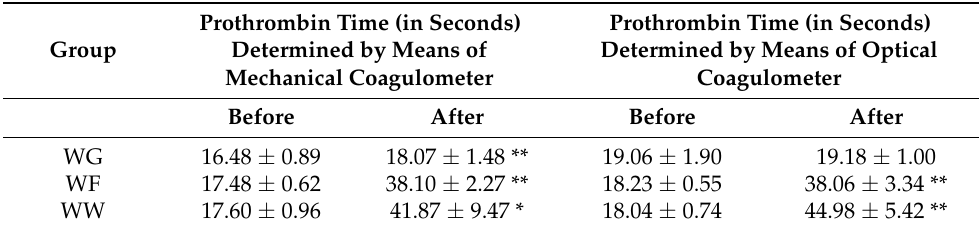
Table 1. Prothrombin times before and after treatment. The data are presented as mean ± SD. (WG: wheatgrass; WF: warfarin; WW: wheatgrass + warfarin). Prothrombin Time (in Seconds) Group Determined by Means of Mechanical Coagulometer